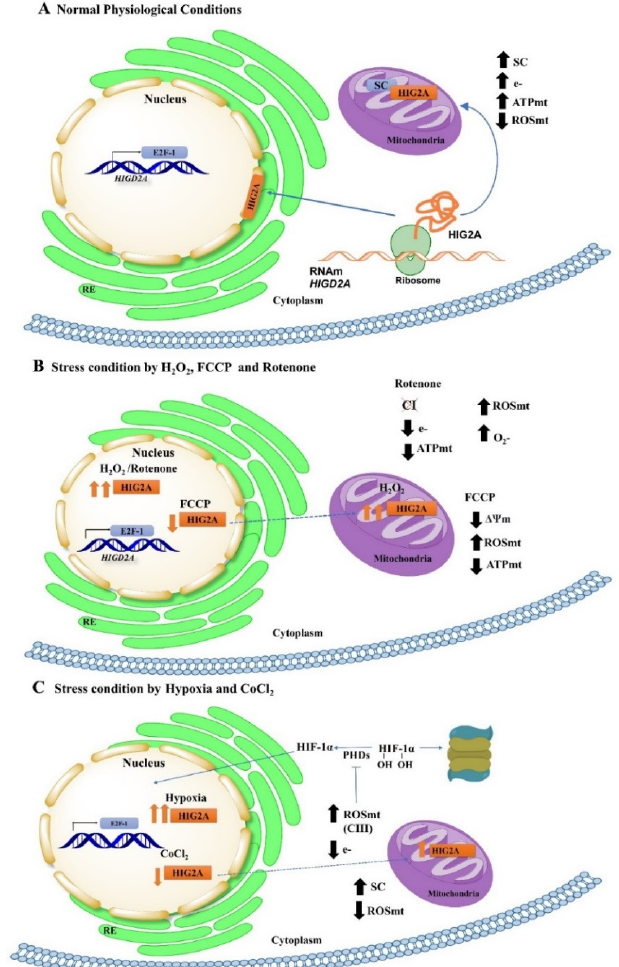
Figure 5. Model of HIG2A behavior in response to stress. ( A ) The transcription factor E2F-1 controls the HIGD2A gene, which encodes the HIG2A protein (in orange) [12]. The model describes two “pools” of HIG2A protein. Once synthesized in the cytoplasm, the HIG2A protein is distributed at the mitochondria and the nucleus [12,17]. Currently, the function of HIG2A at the nucleus has not been described, whereas, at mitochondria, HIG2A is localized in the inner mitochondrial membrane where it participates in the formation of respiratory supercomplexes (SC), interacting with complex III (CIII) and complex IV (CIV), and promoting their stability [8,11,12]. The increase in the formation of respiratory supercomplexes has been associated with a decrease in mitochondrial reactive oxygen species (ROSmt) and an increase in mitochondrial energy generation (ATPmt) [1,2,4,6]. The distri- bution of HIG2A protein at the subcellular level will depend on the type of stress to which cells are exposed. ( B ) Mitochondrial stress by Rotenone (Complex I (CI) inhibitor) causes an increase of HIG2A at the nuclear level. Inhibition at the CI level causes an increase in superoxide anion (O 2- ) generation and a decrease in electron (e-) flow through the electron transport chain (ETC) and mtATP generation [67,68]. In contrast, FCCP causes a reduction at the nucleus, which could suggest (dotted arrow) a shift of HIG2A into the mitochondria to make up for the deficiency in mitochon- drial membrane potential ( ΔΨ m) that is caused by the mitochondrial uncoupler FCCP [69], partici- pating in SC formation, stabilizing electron flow, and maintaining mitochondrial energy generation (mtATP). In comparison, H 2 O 2 (generalized stress) caused an increase in HIG2A at the mitochondria and cytoplasm. H 2 O 2 causes an increase in ROS at the cellular level which may participate in signal- ing pathways. ( C ) It has been described that under hypoxic conditions, the transcription factor HIF-